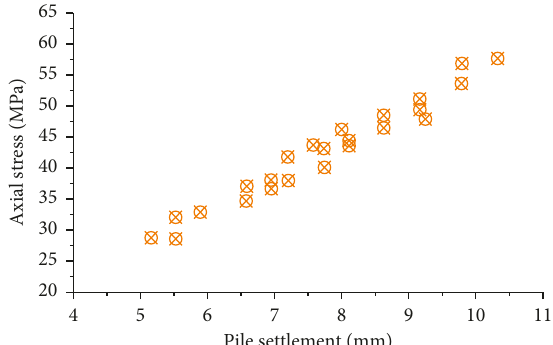
Figure 17: Relationship between pile settlement and axial stress.